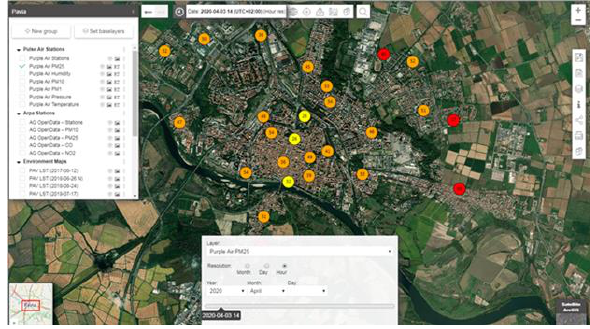
Figure 15. PurpleAir PM 2.5 measurements in Pavia